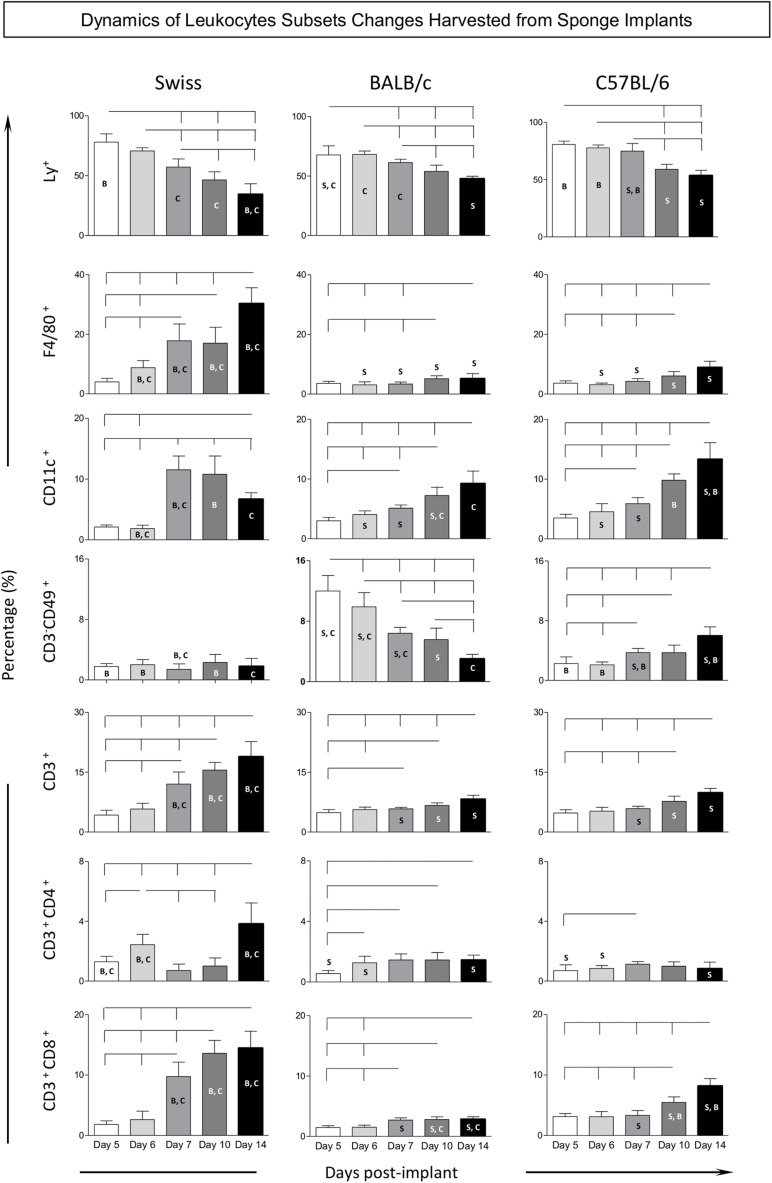
Kinetics of leukocyte subsets harvested from sponge implants. The sponge disks were subcutaneously implanted and removed at Day5, Day6, Day7, Day10, and Day14 post-implant. They were gently squeezed and cell suspension stained with monoclonal antibody for selective flow cytometry quantification of leukocytes subsets (CD45+): innate immunity cells [neutrophils (LY+), macrophages (F4/80+), dendritic cells (CD11c+), and NK-cells (CD3– CD49+)], along with the adaptive immunity cells [T-cells (CD3+), CD4+T-cells (CD3+CD4+), and CD8+T-cells (CD3+CD8+)]. Data are reported as mean percentage of each cell subset ± standard deviation along the days post-implant. Intragroup and intergroup comparisons were assessed. Significant differences at p < 0.05 are underscored by connecting lines within the lineage and by letters “S,” “B,” and “C” for comparisons with Swiss, BALB/c, or C57BL/6 mice, respectively.